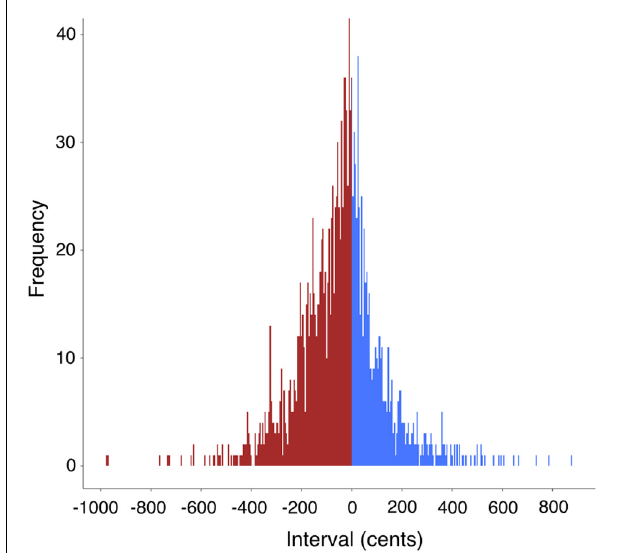
FIGURE 8 | Frequency distribution of interval use in the test corpus. This figure presents the relative frequency of pitch-intervals across the 19 test items and the 19 participants. The y -axis represents the absolute frequency of each interval from a pool of 1700 intervals. Along the x -axis are the intervals expressed as cents changes, where 100 cents is one equal-tempered semitone. Descending intervals are shown in red on the left side, and ascending intervals are shown in blue on the right side, where the center of the distribution is the unison interval having no pitch change (i.e., two repeated pitches), which was color coded as blue. 96% of the intervals occur in the span of –400 to +400 cents.